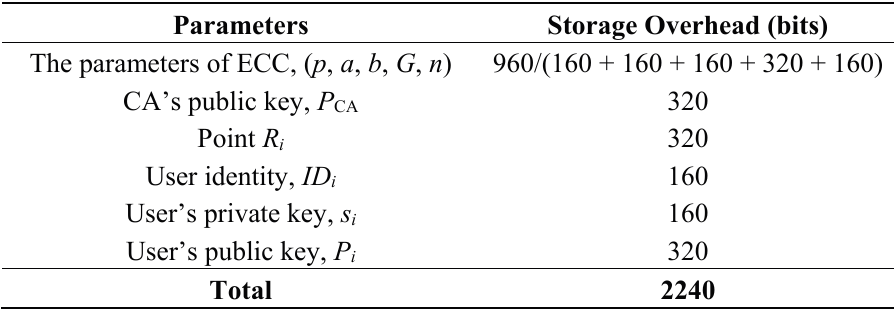
Table 3. Storage overhead of each user.